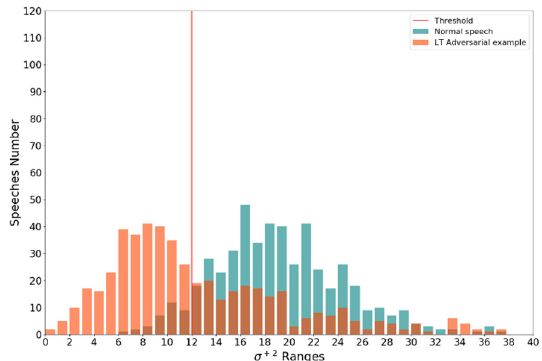
(cid:2878)(cid:2870) feature in Lingvo . Figure 8. Detecting LT adversarial examples by σ + 2 feature in